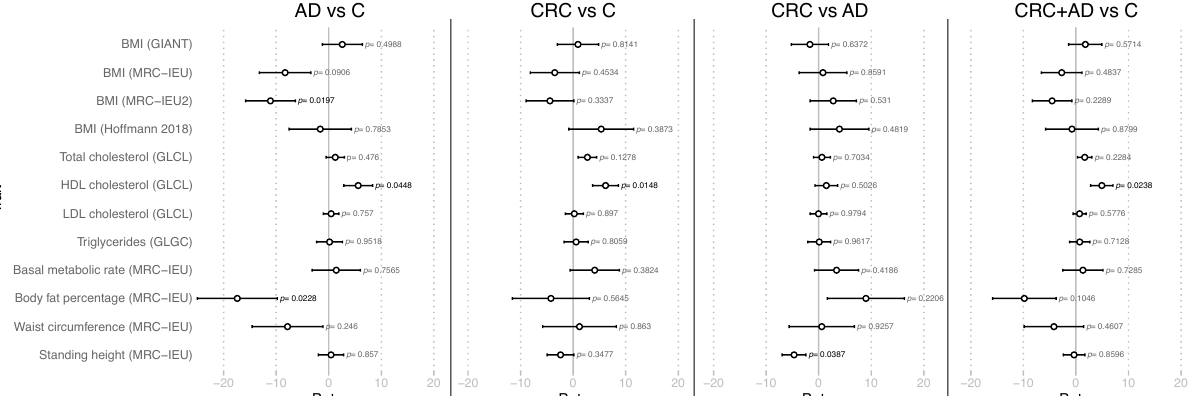
Figure 2. Mendelian Randomization analyses in adenoma and colorectal cancer. AD vs. C, adenoma vs. healthy controls; CRC vs. C, colorectal cancer vs. healthy controls; CRC vs. AD, colorectal cancer vs. adenoma; CRC + AD vs. C, adenomas and colorectal cancer vs. controls. Between parenthesis, the source of the SNPs used as exposure in the